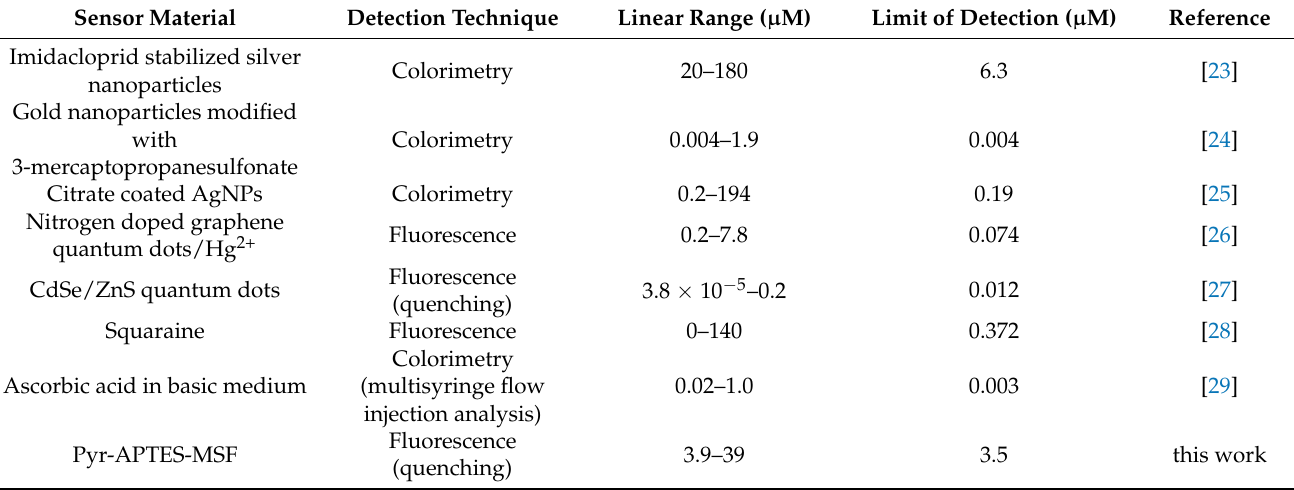
Table 3. Different methods used for detection of